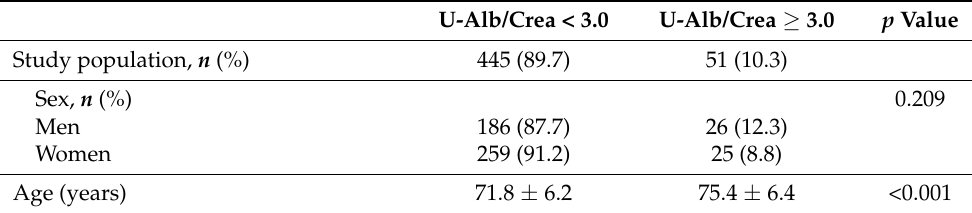
Table 1. Clinical characteristics of the study participants by albuminuria. U-Alb/Crea <